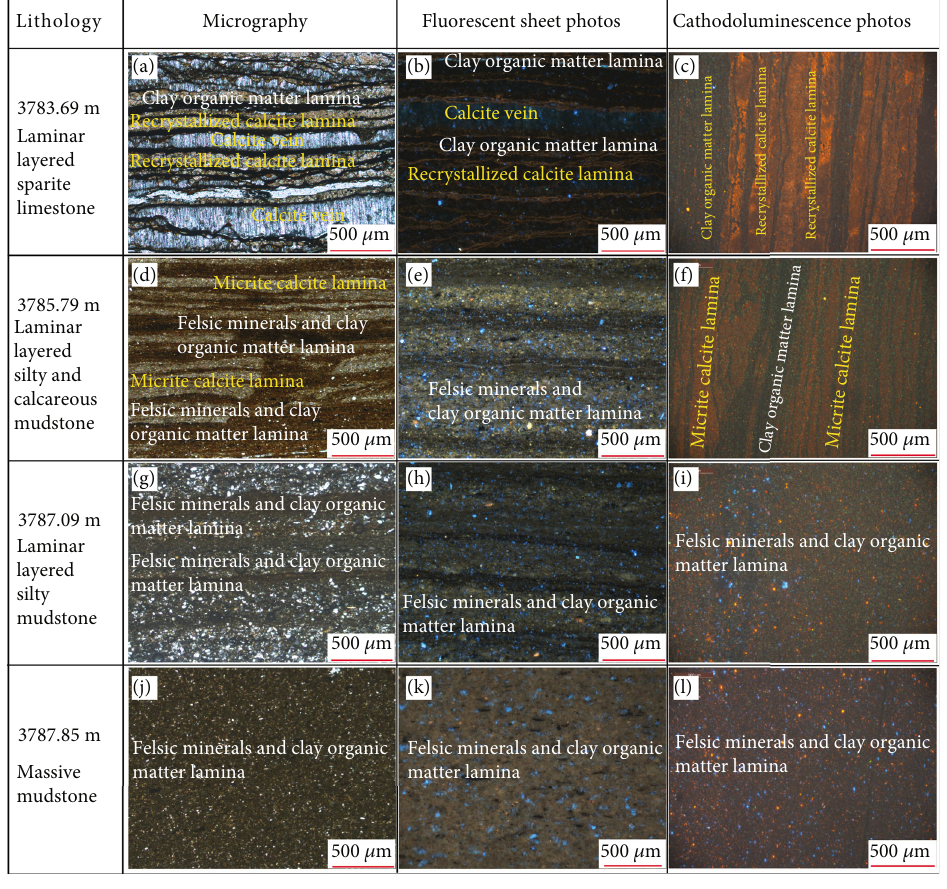
Figure 2: Lithology types of 3783.55 – 3790.63m core section of Nx55. (a) Crossed polarizers photo: laminated argillaceous sparry limestone, clay organic matter lamina, recrystallized calcite lamina, and calcite vein overlap. (b) Fluorescent photo: the overlap of three laminae. (c) Cathodoluminescence photo: clay organic matter and recrystallized calcite laminae overlap. (d) Single polarized photo: micrite calcite lamina, felsic minerals, and clay organic matter lamina overlap. (e) Fluorescent photo: overlap of argillaceous silt, felsic minerals, and clay organic matter lamina. (f) Overlap of micritic calcite and clay organic matter laminae. (g) Overlap of argillaceous silt, felsic minerals, and clay organic matter lamina. (h) Fluorescent photo of argillaceous silt, felsic minerals, and clay organic matter lamina. (i) Cathodoluminescence photo of argillaceous silt. (j) Felsic minerals and clay organic matter. (k) Fluorescent photo of felsic minerals and clay. (l) Cathodoluminescence photo of felsic minerals and